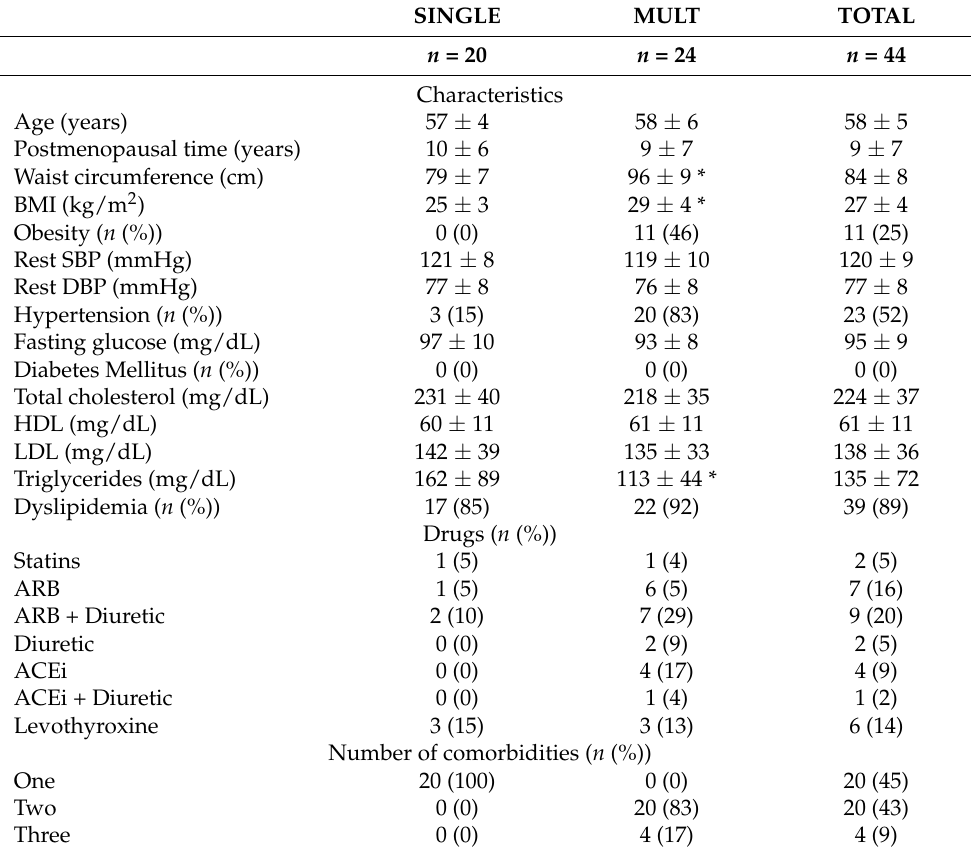
Table 2. Baseline general characteristics, drugs, and